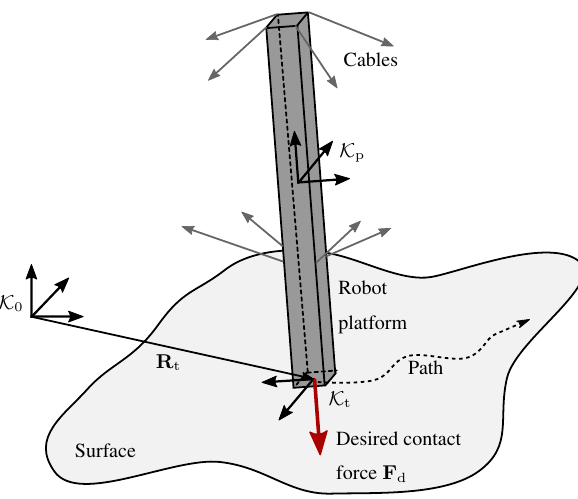
Figure 4. Principle set-up at the mobile platform and coordinate systems for hybrid position-force control.